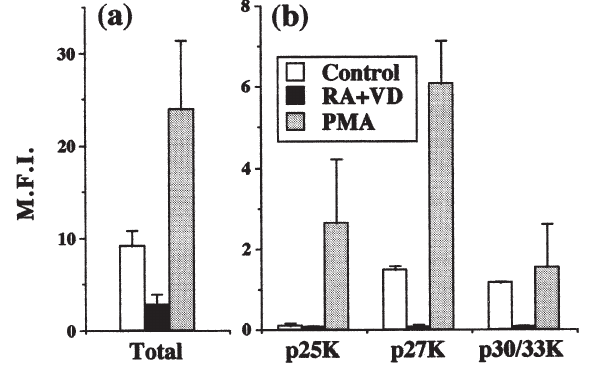
Fig. 8. Flow cytometric detection of proteasomal subunits on the plasma membrane of control and 72 h induced U937 cells. Cells were carefully washed to avoid non-specific binding. (a) Main plasma membrane antigens detected with a panel of 7 monoclonal antibodies. (b) Various proteasomal protein subunits detected with monoclonal